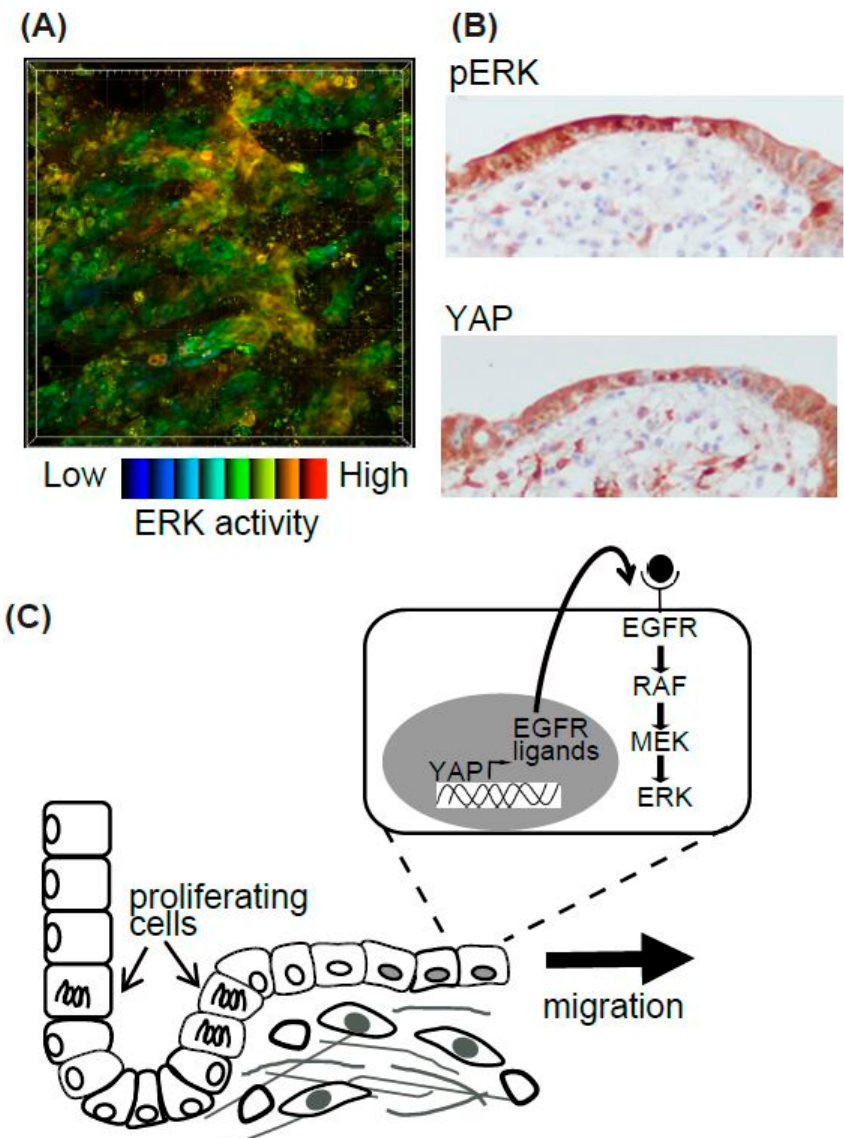
Figure 3. Summary of epithelial cell resealing in the intestine. ( A ) High ERK activity in the resealing epithelial cells in the EKAR-TG mouse intestine. ( B ) The representative images of pERK and YAP IHC in the human intestinal ulcer. ( C ) The working model of the resealing epithelial cells after injury.